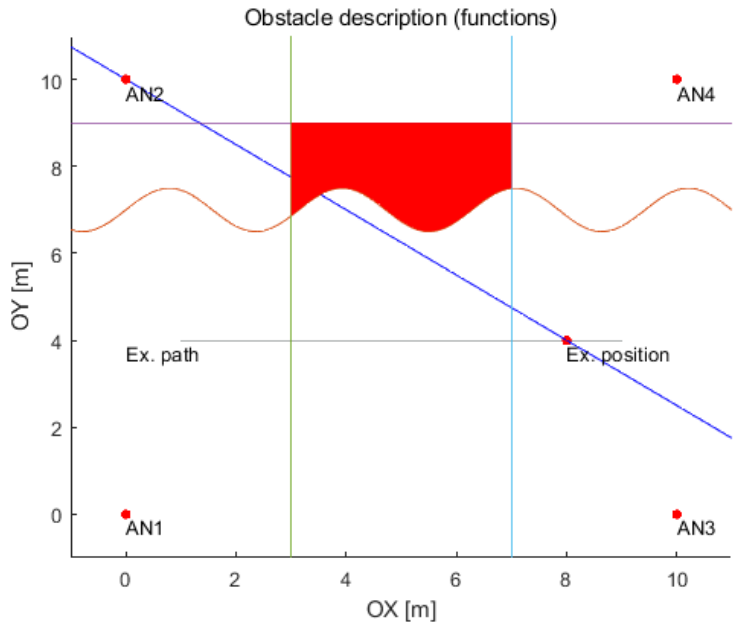
Figure 18. Example of the obstacle description and NLOS detection for the selected point on the path.